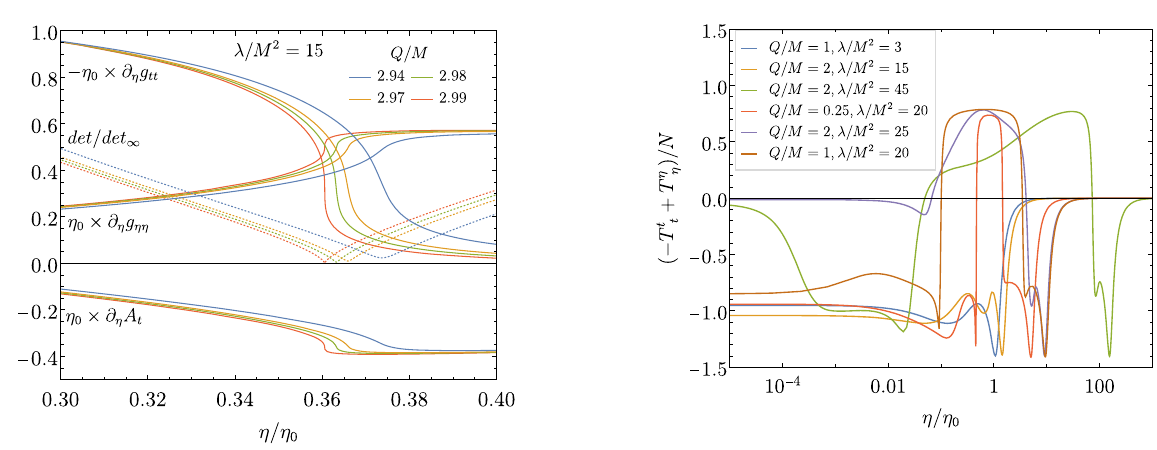
Fig. 17 Formation of a cusp for λ/ M 2 = 15. Shown are several func- tions and derivatives as function of η/η 0 for several values of Q / M , approaching the critical value Q / M = 3 . 01